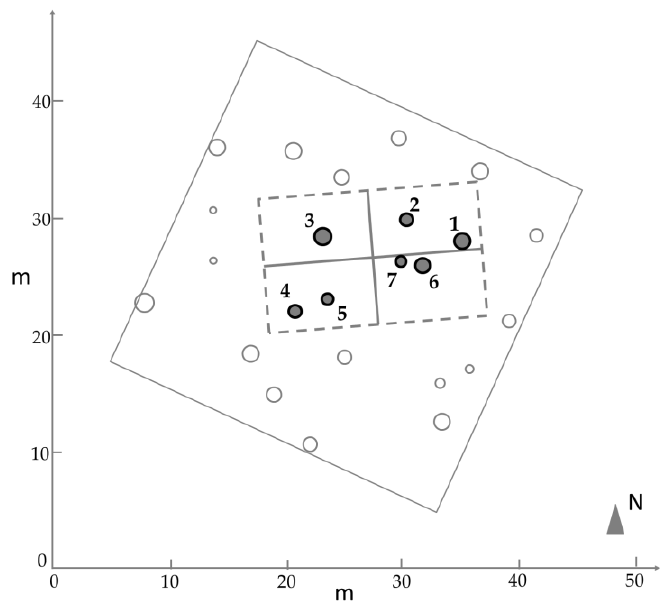
Figure 1. Forest plot that was used for the experiments. The dashed rectangle indicates the group of trees that were selected for 3D reconstruction.